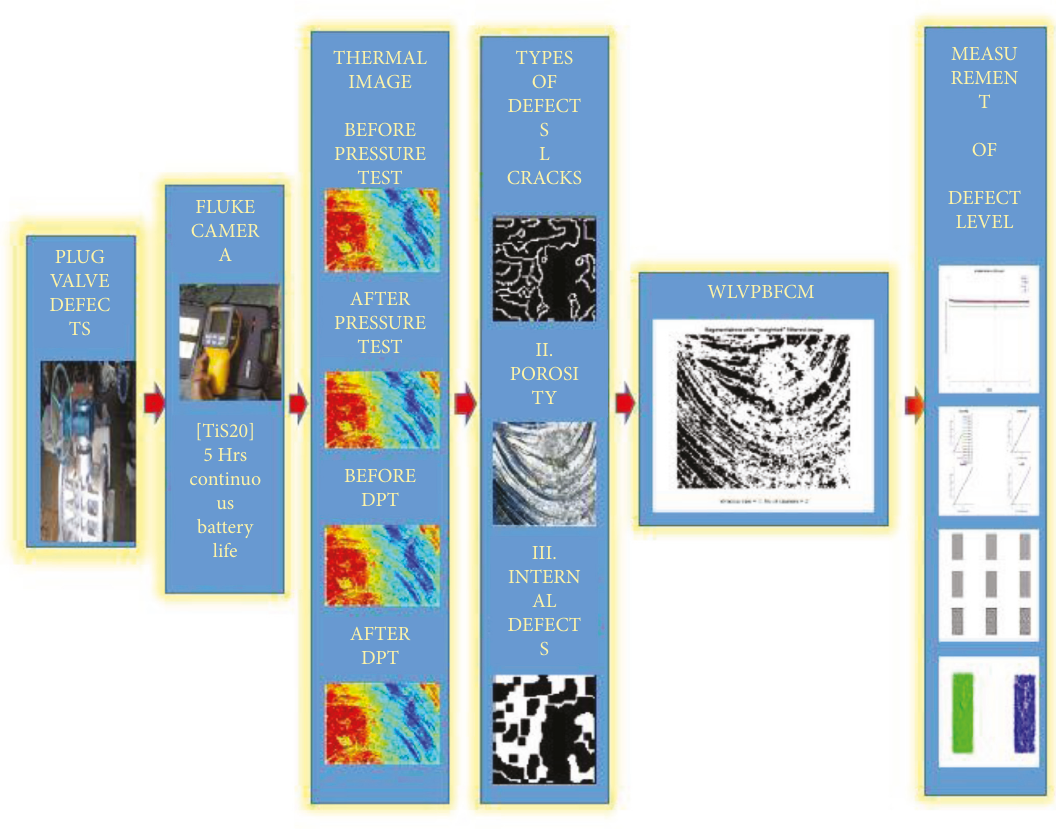
Figure 1: Block diagram of the proposed